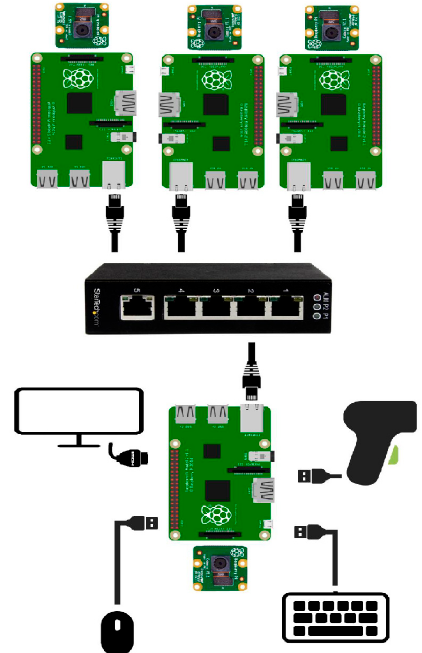
Figure 2. The hardware architecture of the IP-LC-FD experimental model.